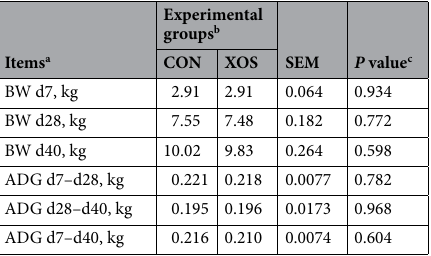
Table 1. Effects of the XOS supplementation on growth performance. a BW Body weight, ADG Average daily gain. b CON Piglets supplemented with water, XOS Piglets supplemented with XOS. c P value obtained from ANOVA